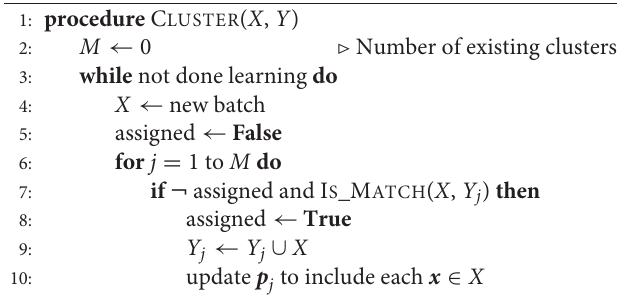
Algorithm 1 : Clustering algorithm by which a new batch